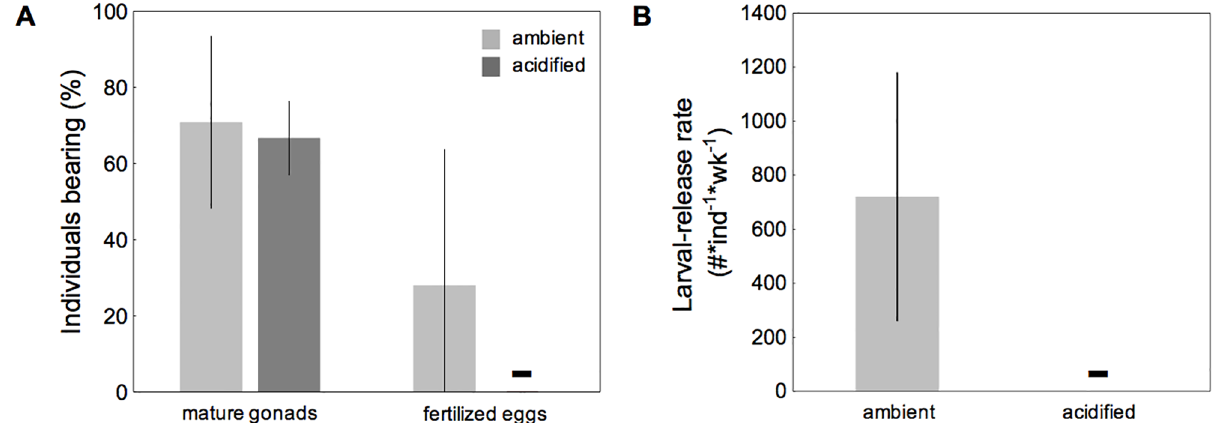
Fig 4. Reproductive maturity (A) and larval release rates (B) of field-collected barnacle assemblages. B . improvisus was incubated at two different pH treatments ( Δ of 0.6 pH units) for 8 months. Reproductive maturity was assessed after 8 months (A); the sum of larvae released per individual barnacle over one week was assessed after 7 months (B). Presented are proportions of barnacles, which developed either mature gonads or fertilized eggs. Deviations denote 95% CIs from the mean (N =